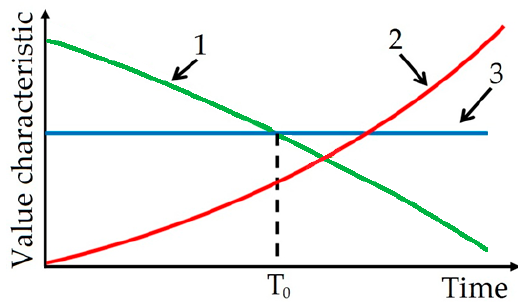
Figure 3. Total economic loss caused by the long-term MMPW storage. 1—declining market value of the mineral resources in the waste dump; 2—environmental costs; 3—conventional recovery costs from the mining waste dump.